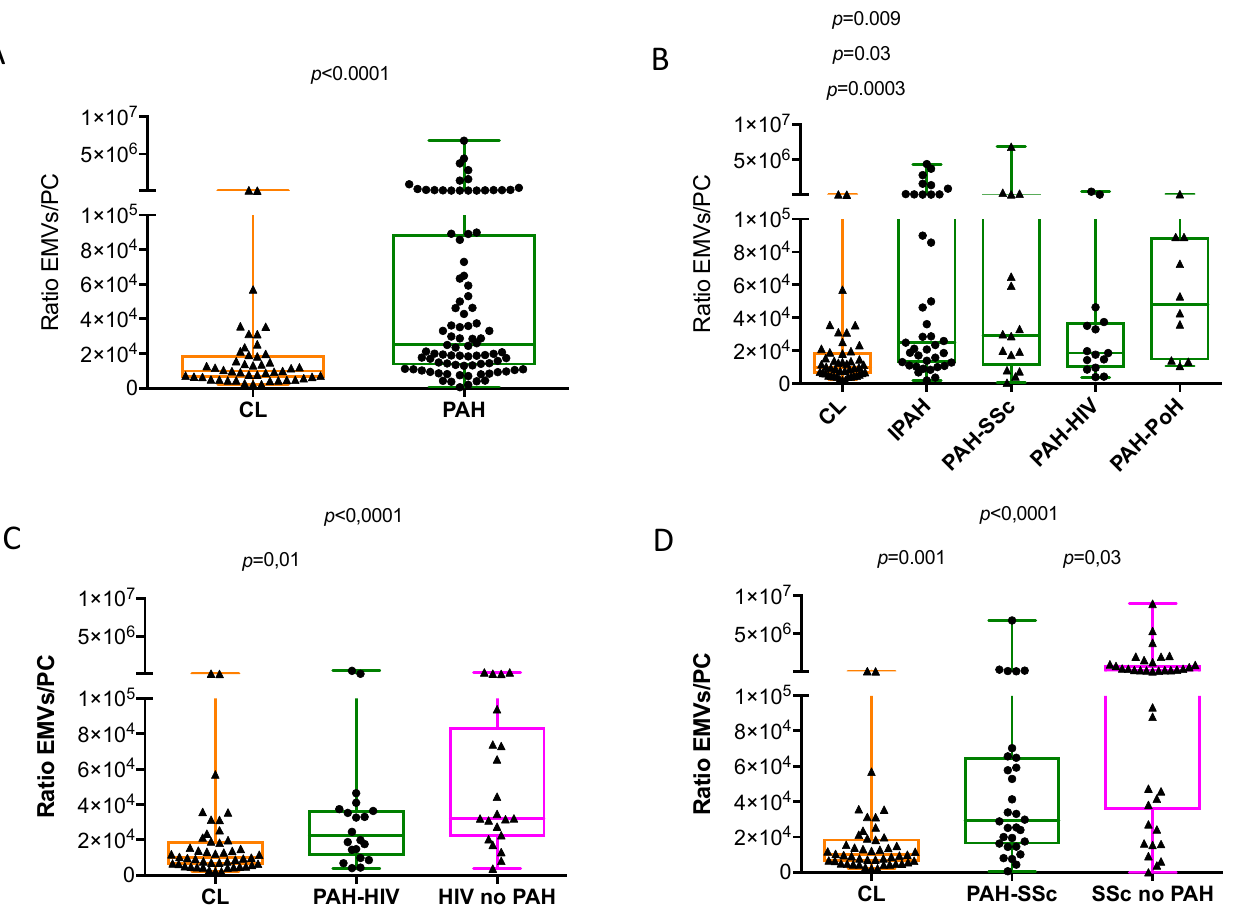
Figure 3. Ratio of EMVs/PCs in pulmonary arterial hypertension, scleroderma and HIV infection and healthy controls.Ratio between CD31 + CD42b − endothelial microvesicles, expressed per μ L of poor platelet plasma and percentage of CD34 + CD133 + CD45 low labelled cells (EMVs/PCs ratio) in ( A ) patients with pulmonary arterial hypertension (PAH) versus healthy controls; ( B ) all the different PAH subtypes versus healthy controls; ( C ) patients with HIV infection, with or without associated PAH; ( D ) patients with scleroderma, with or without associated PAH. Mann Whitney Rank Sum test and Kruskal-Wallis One Way Analysis of Variance and when significant post-hoc Dunn’s multiple comparisons test.